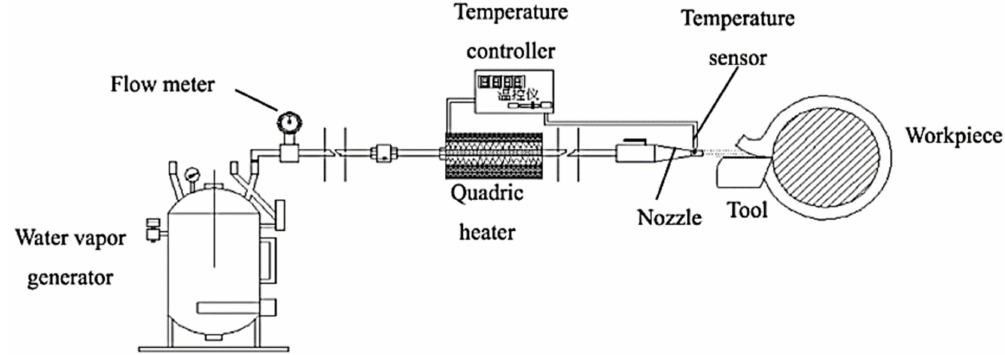
Figure 31. Vapor generator device and feeding system, reprinted with permission from ref. [173]. Copyright 2004 Else- vier Ltd.